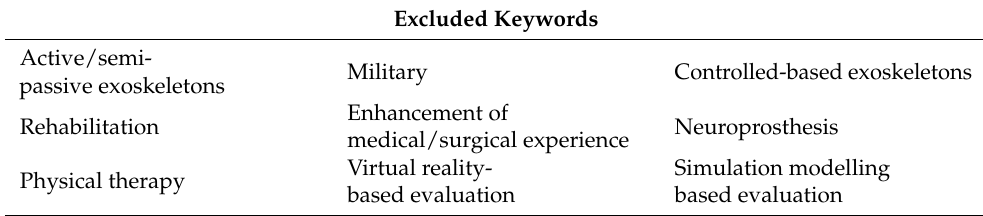
Table 2. Exclusion criteria for literature review.